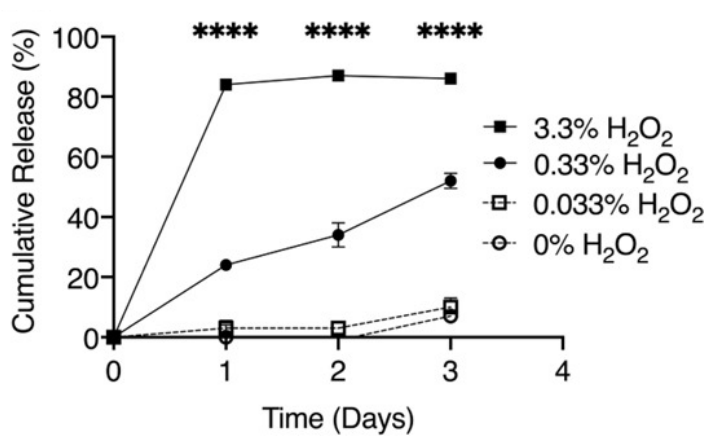
Figure 3. Cumulative release of diflunisal from poly(propylene sulfide) nanoparticles with different concentrations of the oxygen-derived radicals H 2 O 2 . **** p < 0.0001. Reproduced from [23], with permission from John Wiley and Sons, 2021.